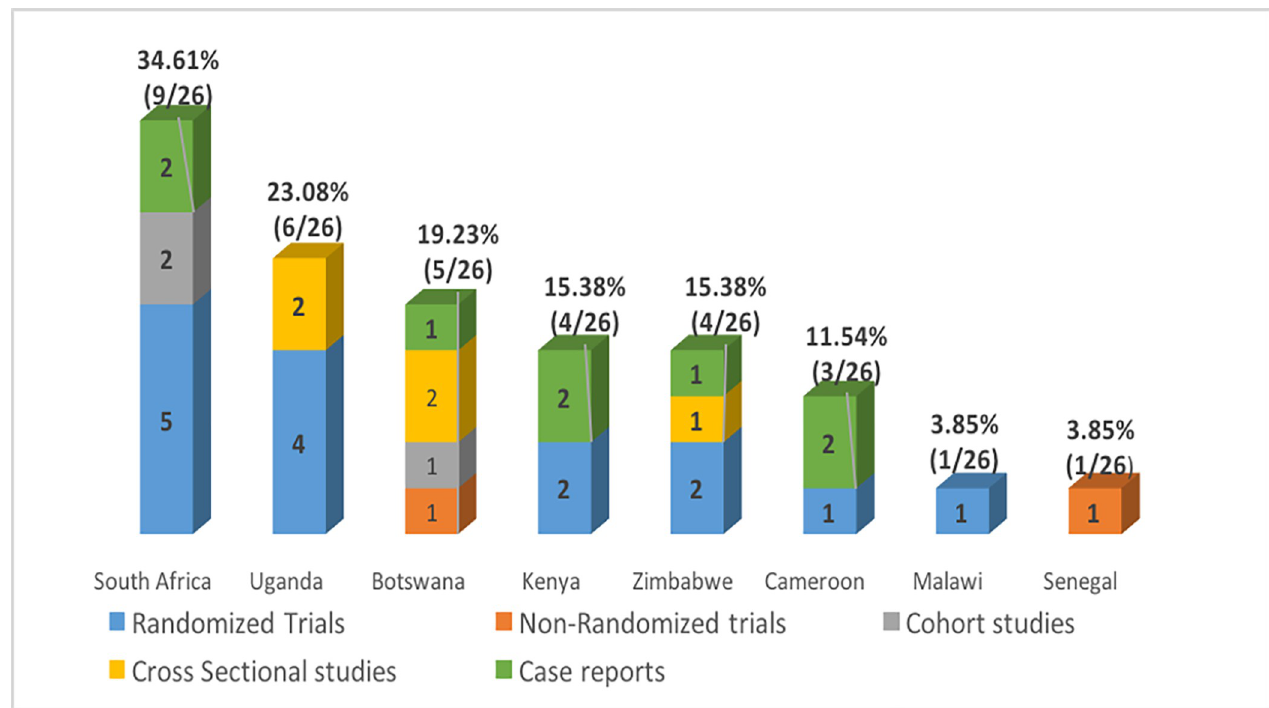
Fig 3. Distribution of included studies according to countries and study designs; at least one country in every sub-regions of sub-Saharan Africa is represented.